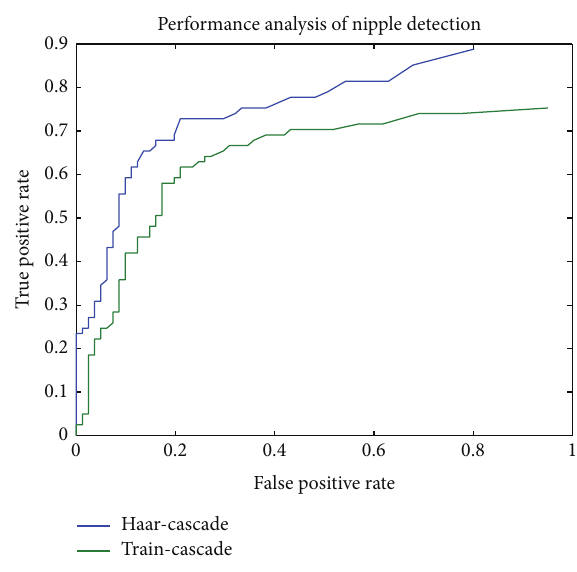
Figure 4: ROC for two